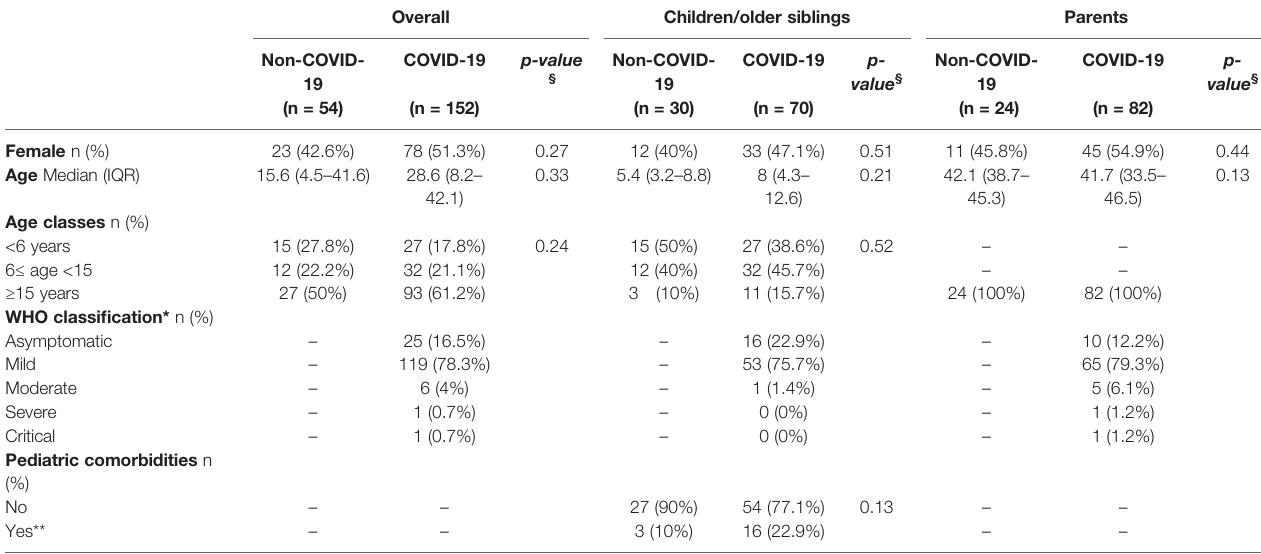
TABLE 1 | Descriptive analysis of the 57 families studied at the Department of Women ’ s and Children ’ s Health of the University Hospital of Padova